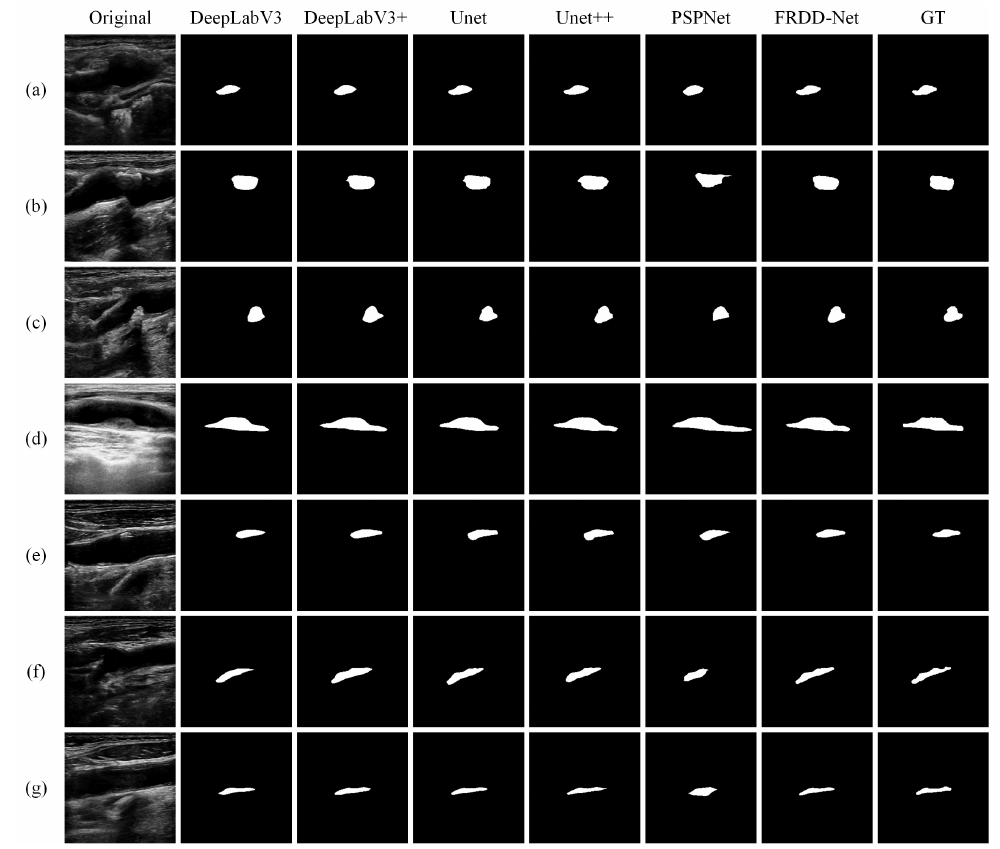
Figure 4. Qualitative comparison of carotid plaque segmentation results produced by FRDD-Net and other methods (DeepLabeV3, DeepLabeV3+, Unet, Unet++, and PSPNet) against ground truth (GT). ( a – g ) are partial segmentation